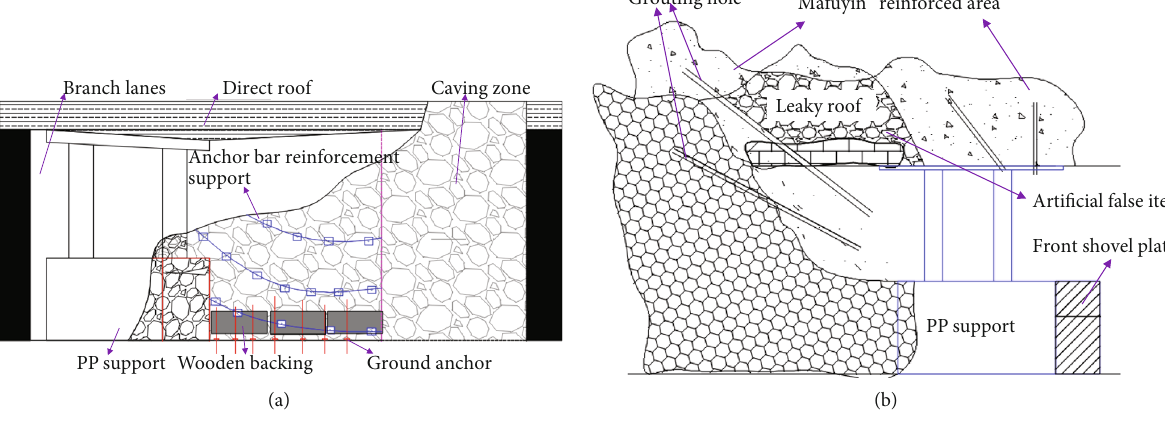
Figure 9: Schematic diagram of the PP support. (a) Diagram for gangue pile reinforcement. (b) Grouting